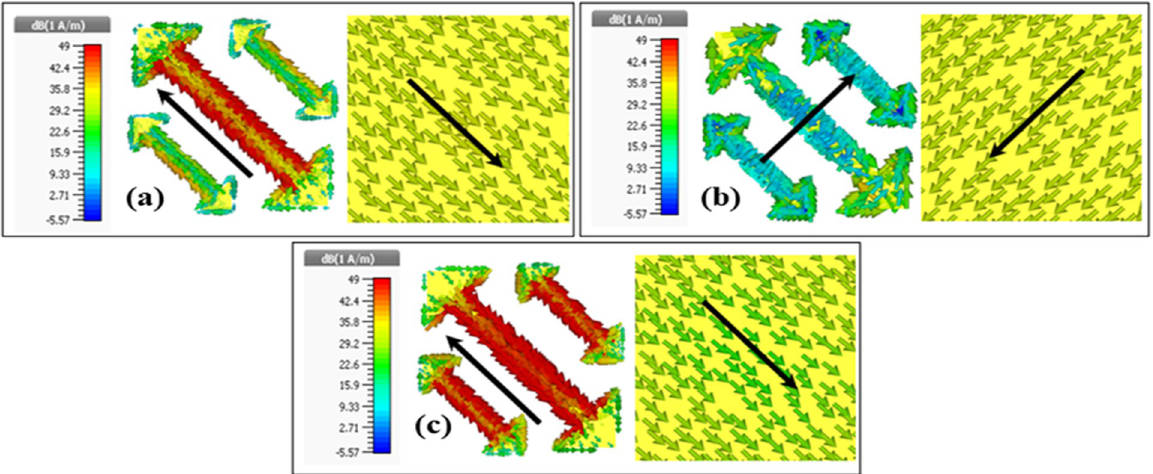
Fig 5. Surface current distributions on top and bottom plane at three different resonance frequencies (a) 9.28 GHz (b) 13.91 GHz (c) 17.80 GHz.